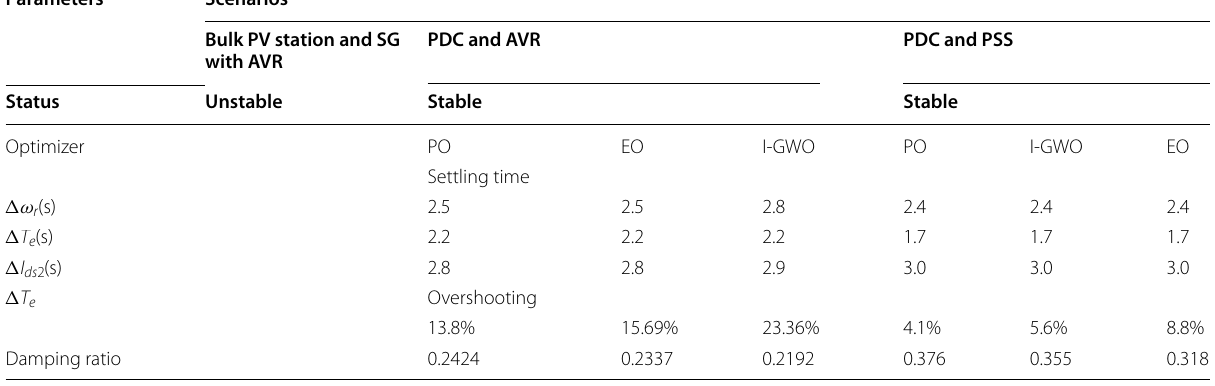
Table 6 The comparison of previous scenarios Parameters